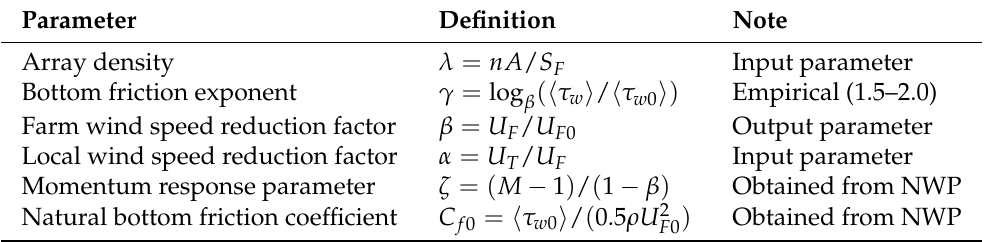
Table 2. Summary of the non-dimensional parameters in the approximated farm momentum Equation